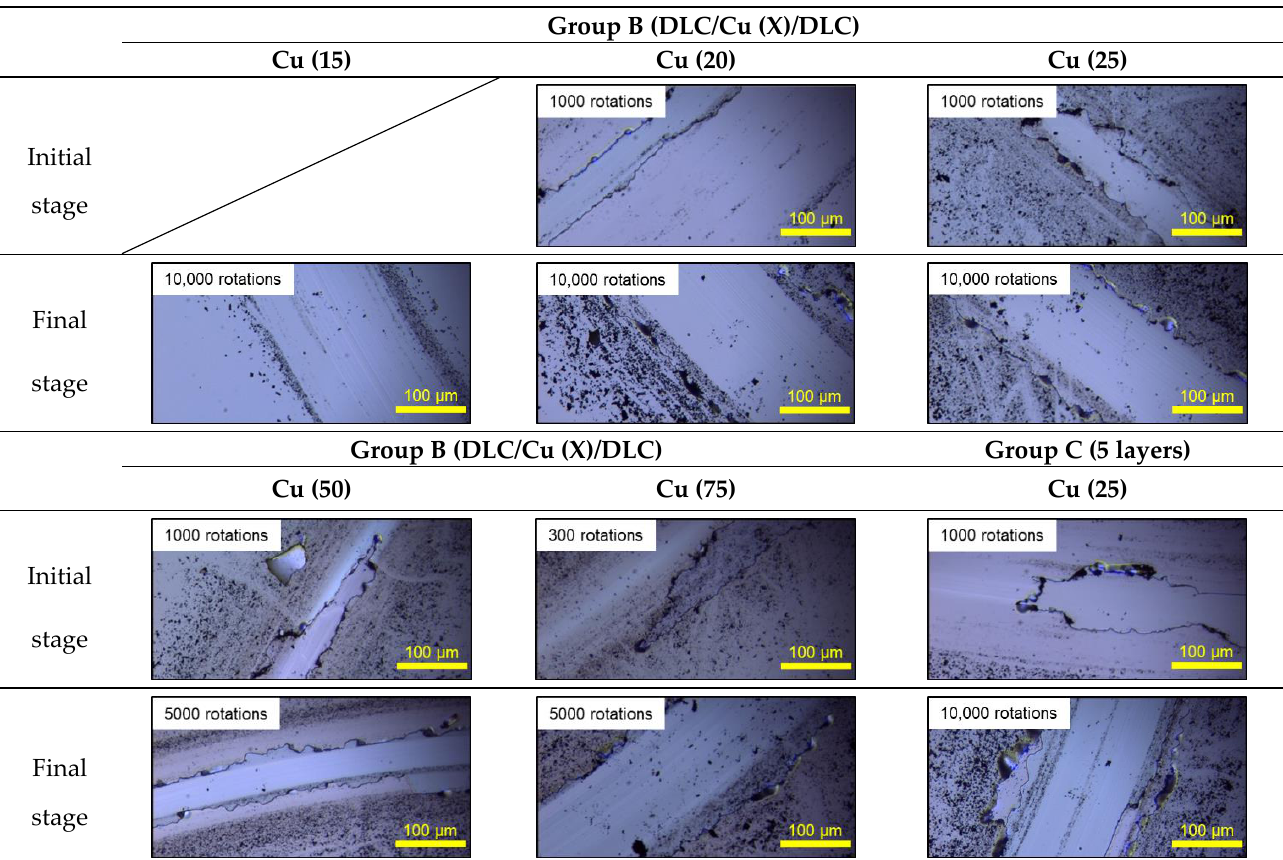
Figure 12. Images of the wear track of the films.